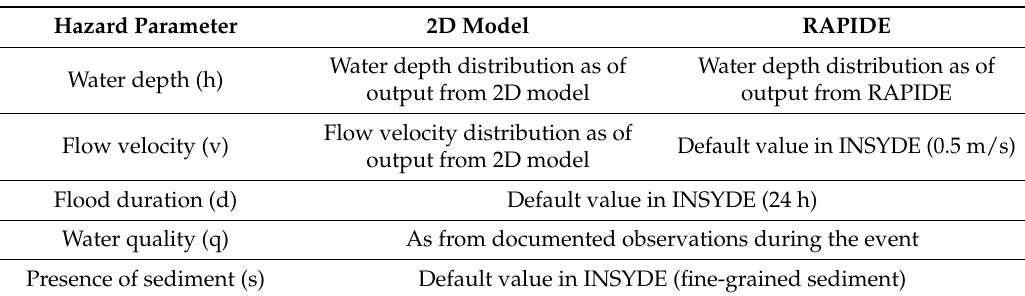
Table 2. Hazard parameters considered in INSYDE, in the case of application of the results deriving from the 2D model and RAPIDE.